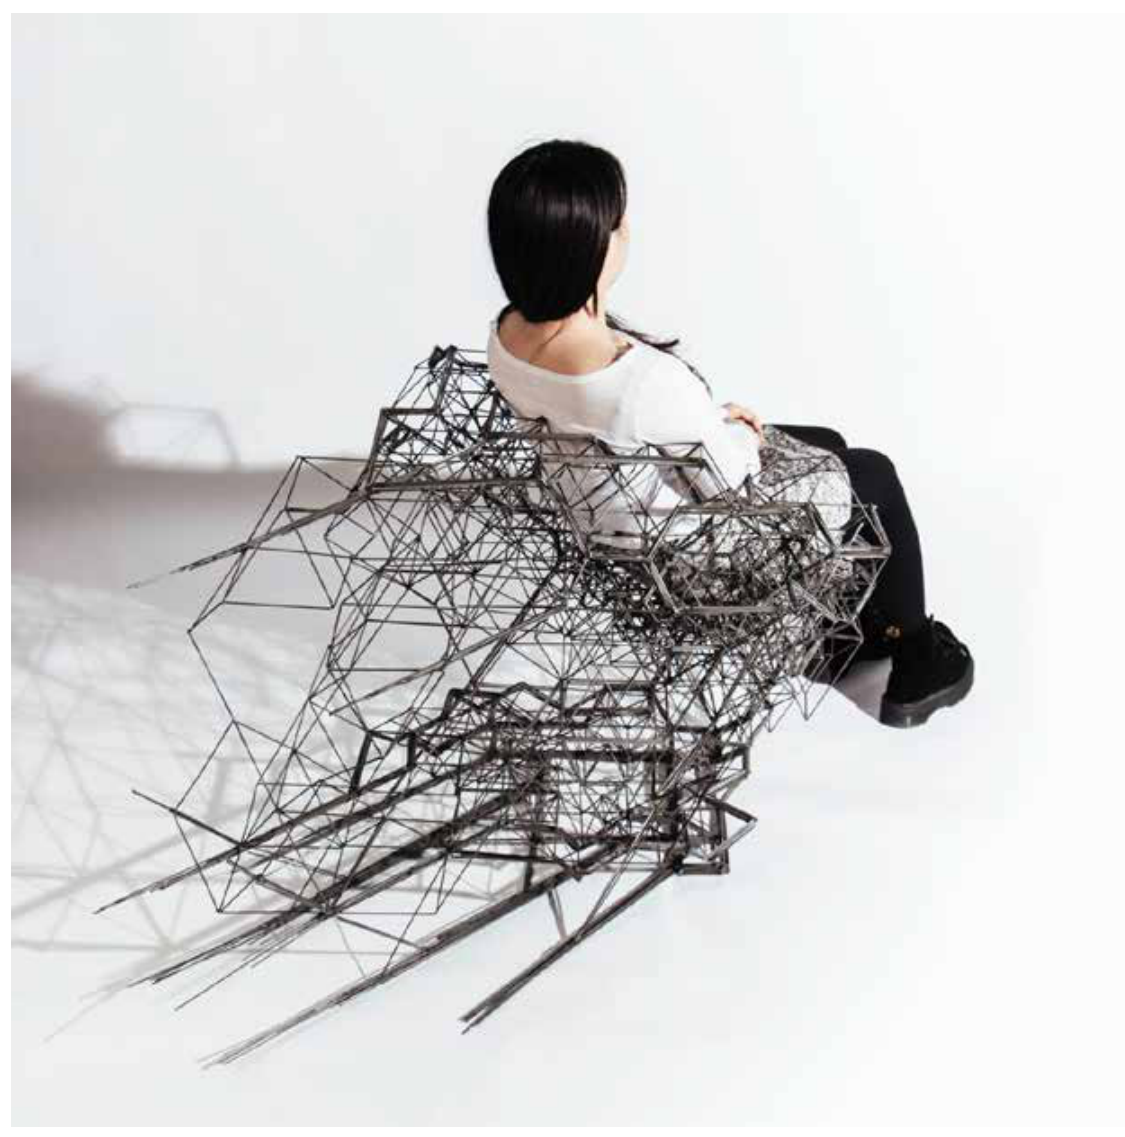
Figure 10—13 (page 89—92): Spacestream (2015). Steel. Design: Daniel Widrig, Soomeen Hahm and Stefan Bassing. Team : Zhen Shan, Mengying Li, Wenjian Yang and Shaoru Wang. Source: